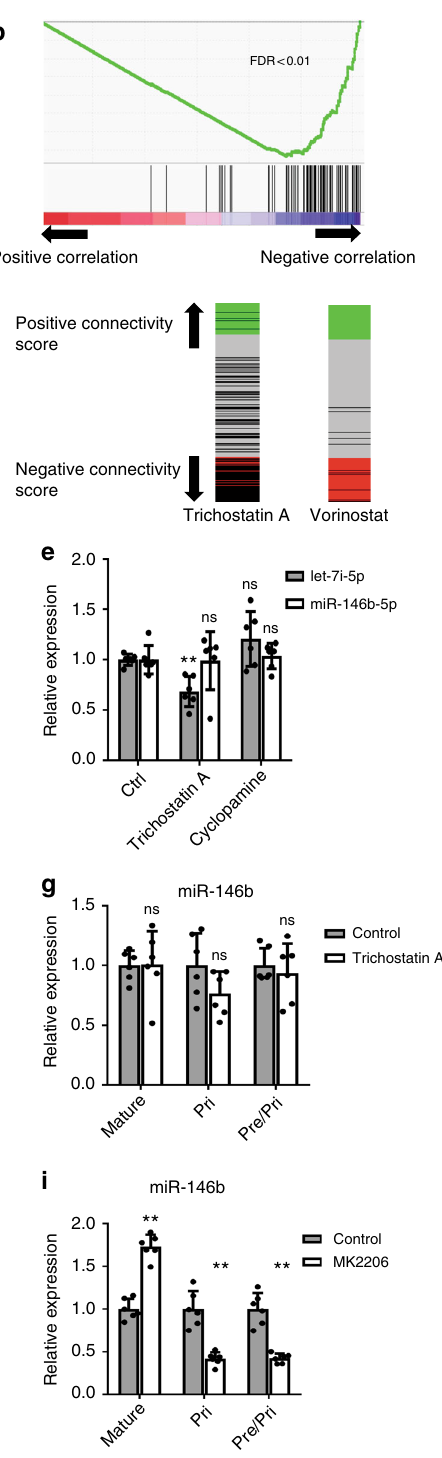
and miR-146b-5p (Fig. 5b and Supplementary Data 3). Interest- ingly, protein translation was also identi fi ed as a molecular process differentially expressed between the major mRNA transcriptomic subtypes (Fig. 3c). We hypothesized that a common upstream regulator controls cellular translation and miR-146b-5p expression in opposite ways. Given that the AKT pathway positively regulates cellular translation, we thus tested the hypothesis that inhibition of AKT could elevate miR-146b-5p NATURE COMMUNICATIONS| (2019) 10:95